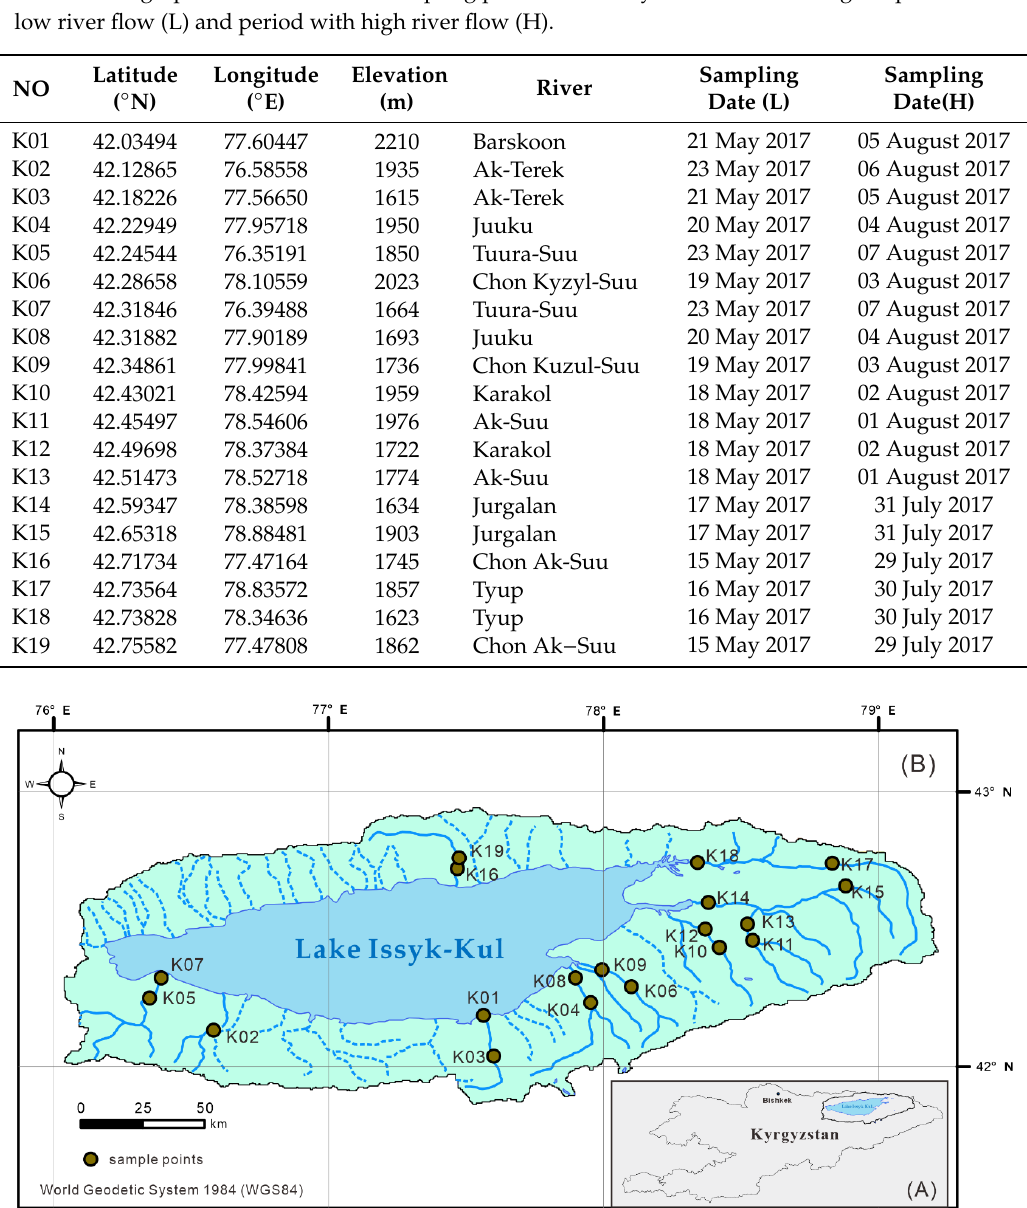
Figure 1. Location map of the Issyk − Kul Basin in Kyrgyzstan (A) and the distribution of the river water samples (B).